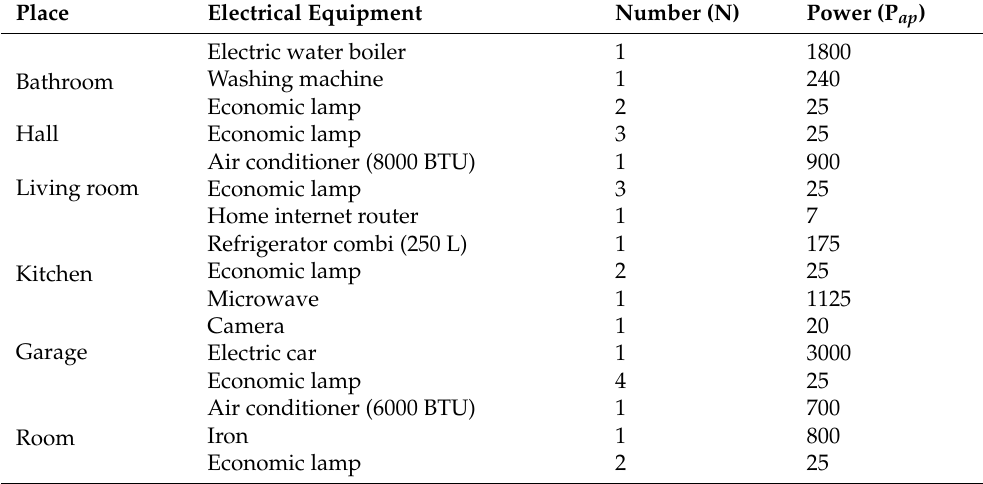
Table 6. Electrical